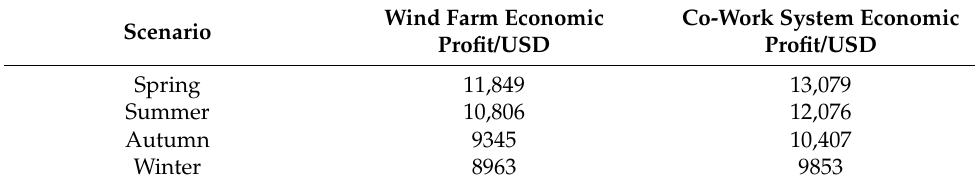
Figure 5. Power of a hybrid wind power and battery energy storage system considering the electricity prices during a day in each of the four seasons. Table 3. Economic benefits of the wind farm in different